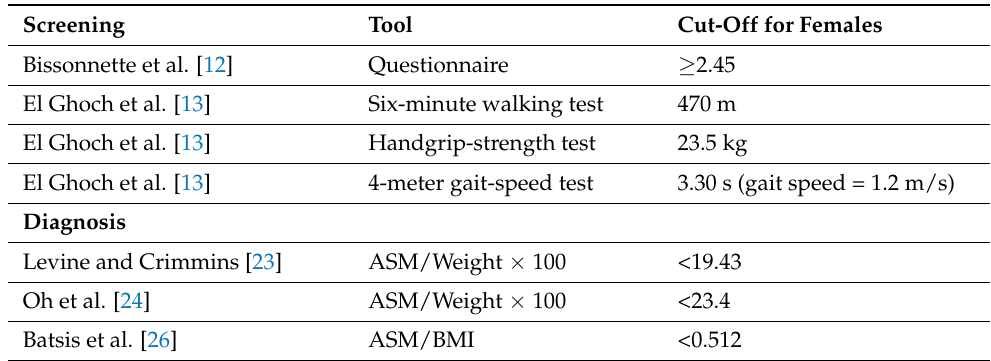
Table 1. Initial screening tools and diagnosis cut-offs for SO in young and middle-aged female adults in a weight management